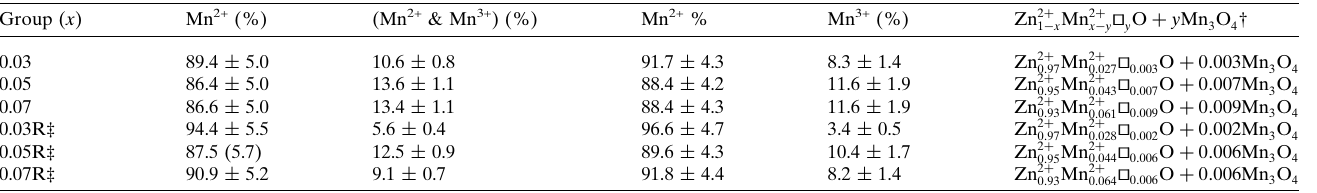
† The ut symbol represents the Zn vacancies equals to the amount % of Mn 3 O 4 impurity phase. ‡ R is the (cid:2) -irradiated sample.